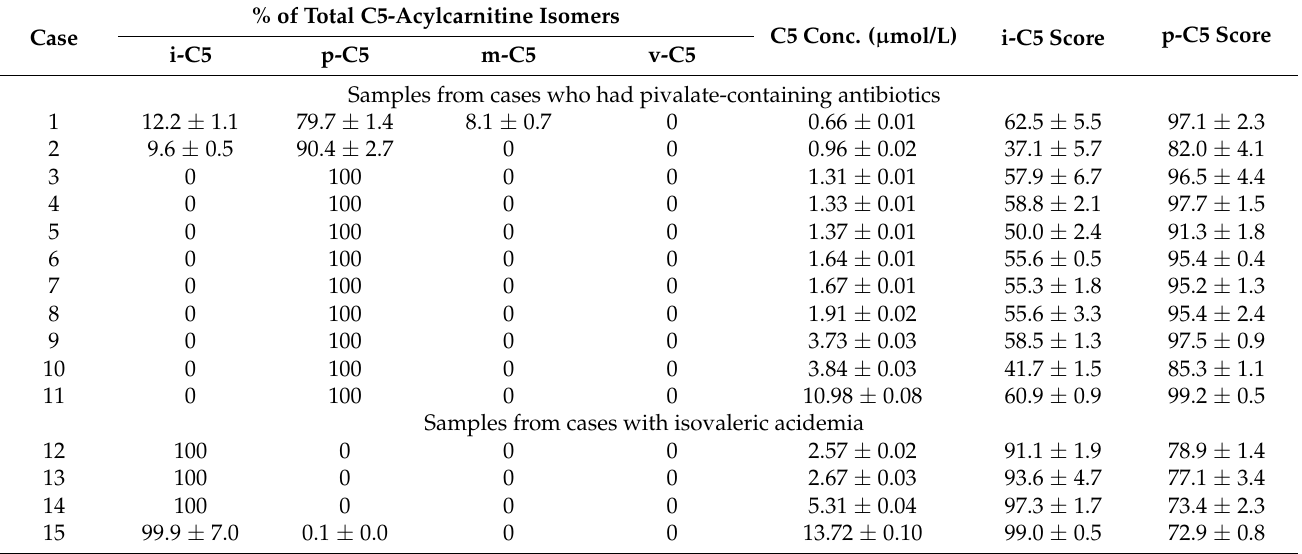
Table 1. Analysis results of 15 DBS